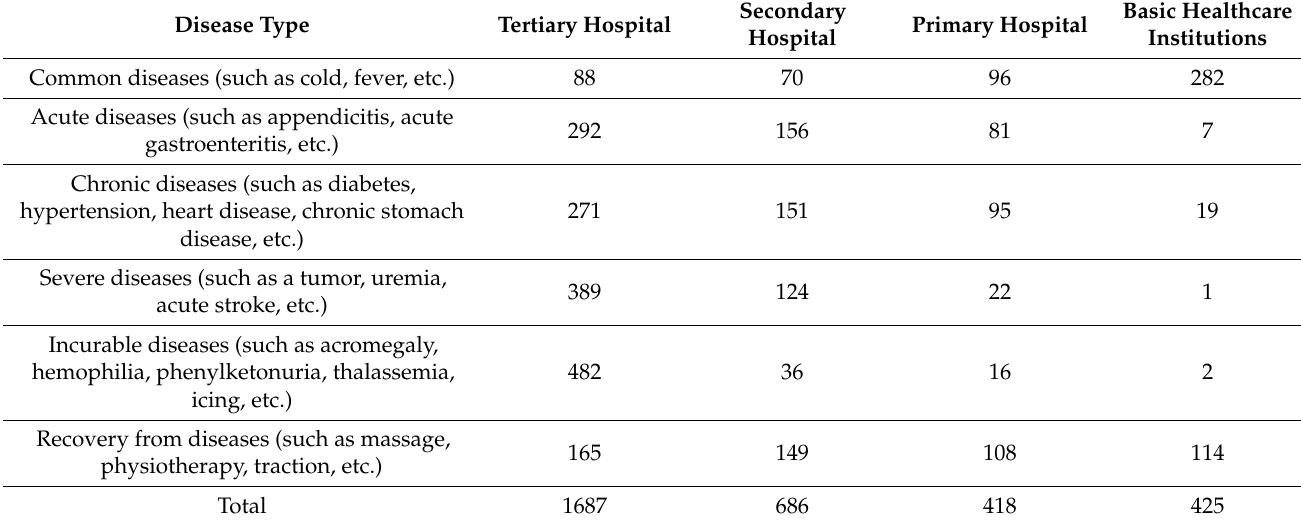
Table 7. Statistics of medical choices for different types of